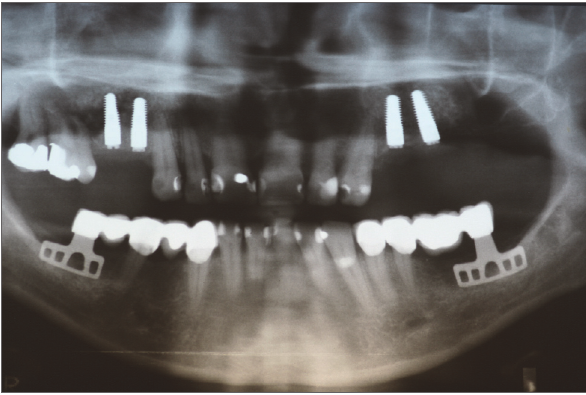
Fig. 5. State after the PV I implant insertion and bilateral augmentation of sinus